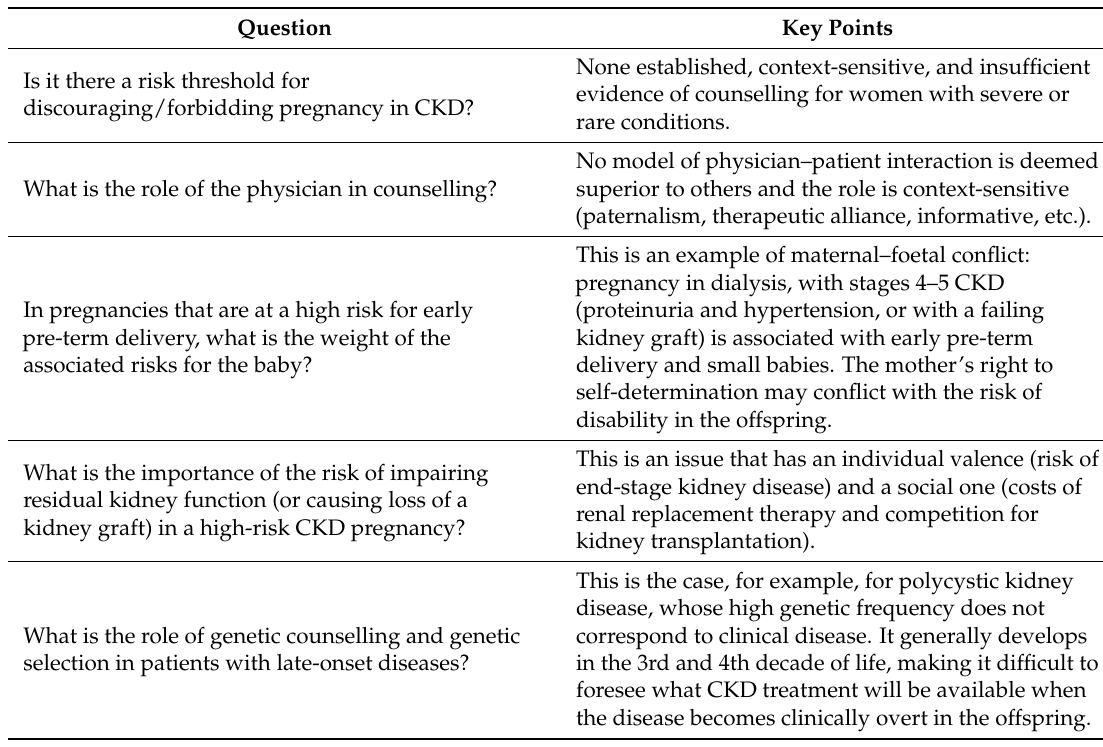
Table 1. Some bioethical questions waiting for answers regarding pregnant women with chronic kidney disease (CKD) and related